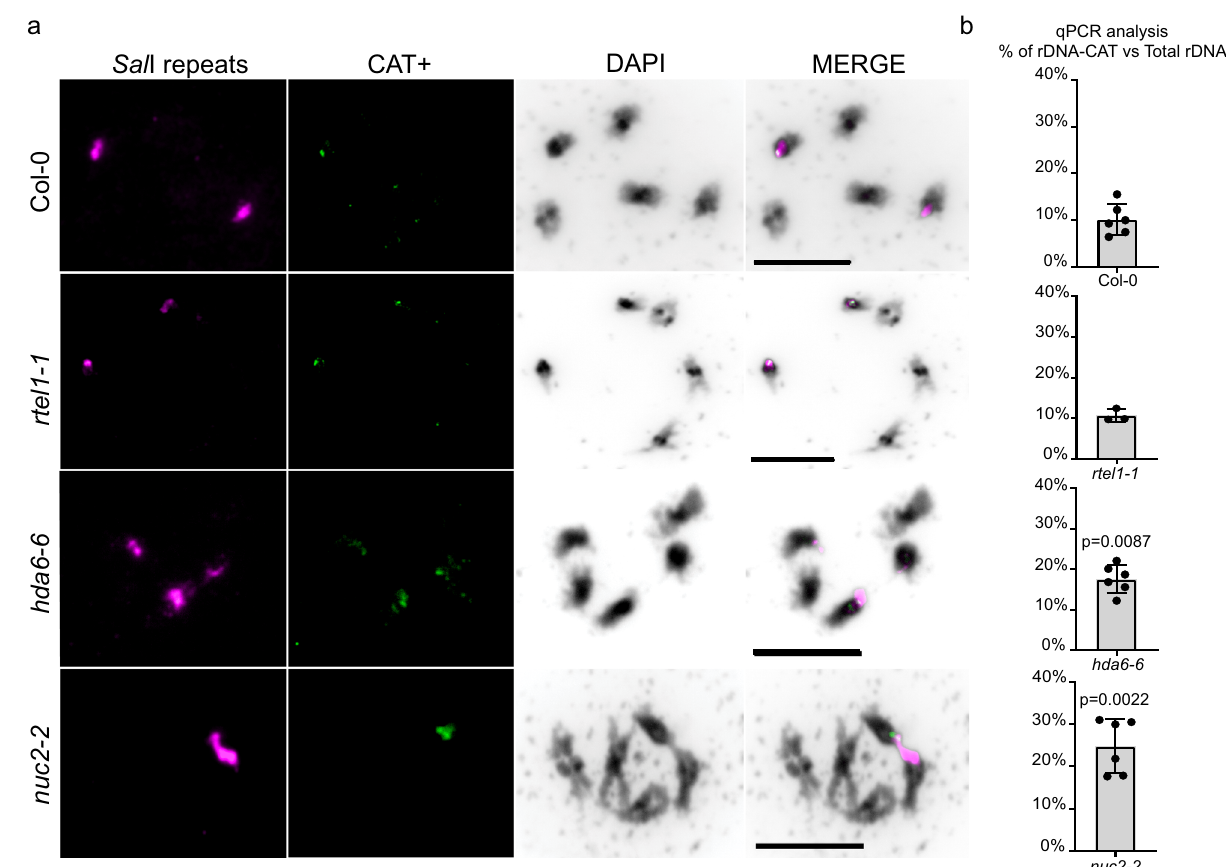
Fig. 4 Visualizing the rDNA-CAT cluster on NOR2. a Spread nuclei from pollen mother cells at diakinesis or metaphase I stages from wild type (Col-0) and mutant lines ( rtel1-1 , hda6-6 , nuc2-2 ) hybridized for the SalI repeats (magenta), the CAT insertion (CAT + , green), and stained with DAPI (black). The experiment was repeated three times with similar results. b Graphs of qPCR experiments from wild type (Col-0) and indicated mutant lines depicting the percentage of rDNA repeats bearing the CAT insertion related to the total amount of rDNA repeats. There is a statistically signi fi cant ( p ≤ 0.001) increase in rDNA-CAT copy number in hda6-6 and nuc2-2 mutant lines. Statistical analysis was performed using the Mann – Whitney test. Error bars represent the